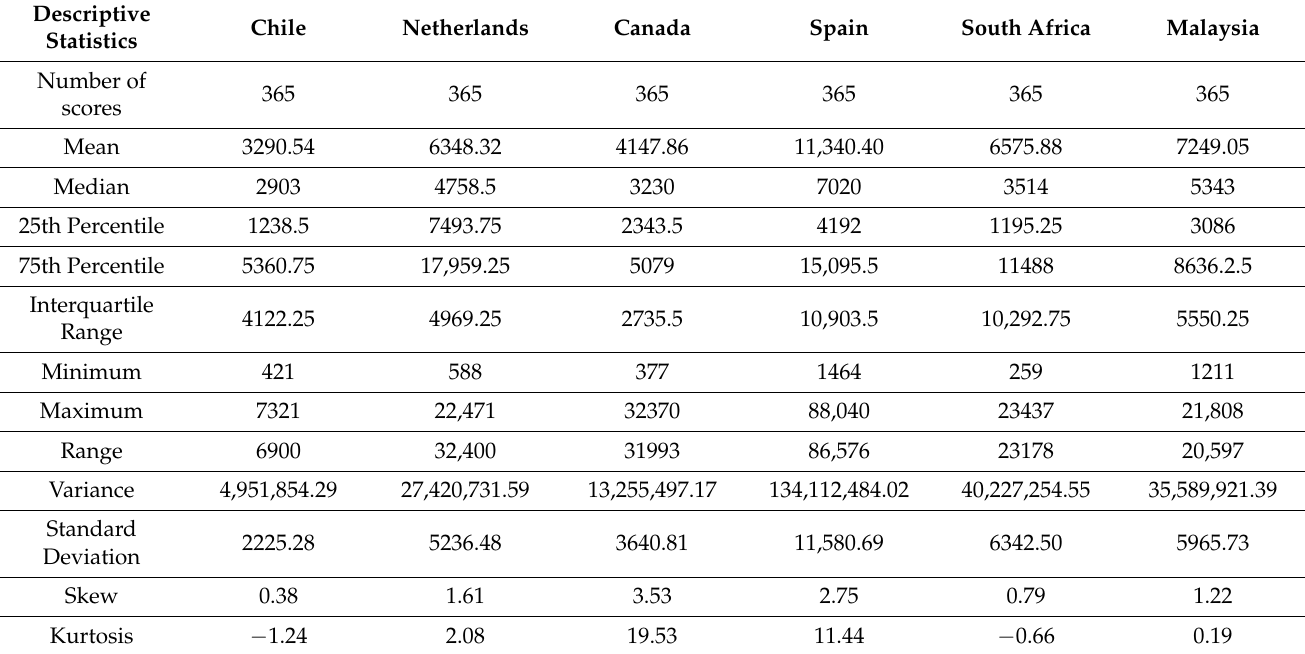
Table 1. Descriptive statistics of the COVID-19 daily spread datasets for Chile, the Netherlands, Canada, Spain, South Africa, and Malaysia for